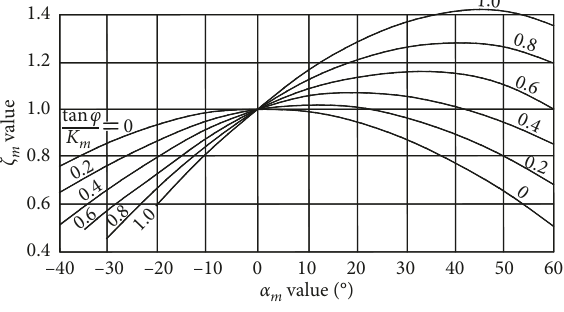
Figure 4: The curve of ζ